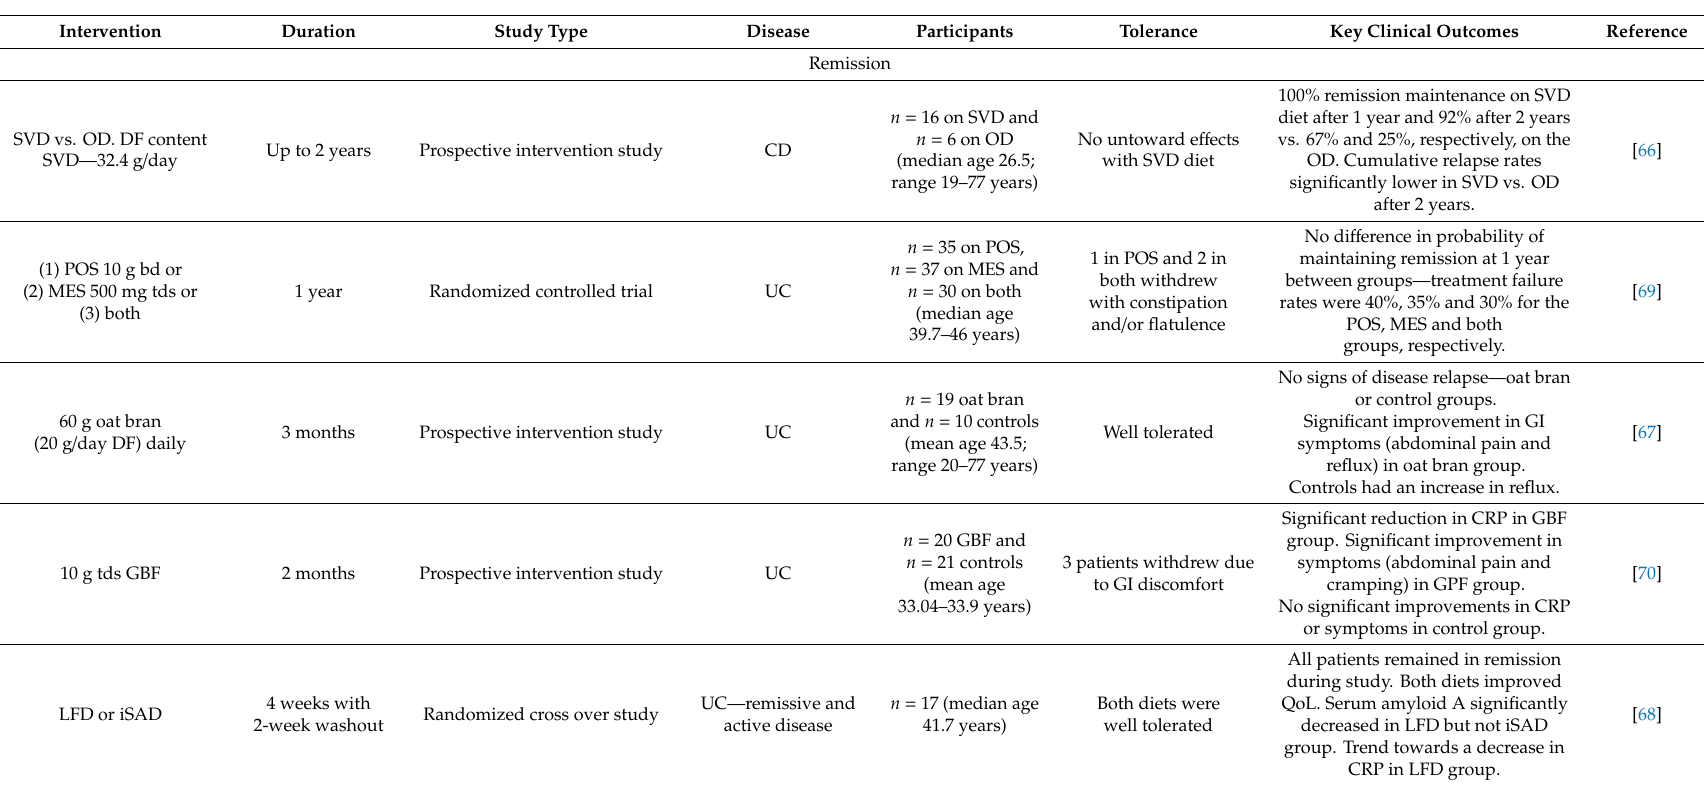
Table 1. Food- and supplement-based fiber and prebiotic intervention studies in adults with IBD in remission or during active